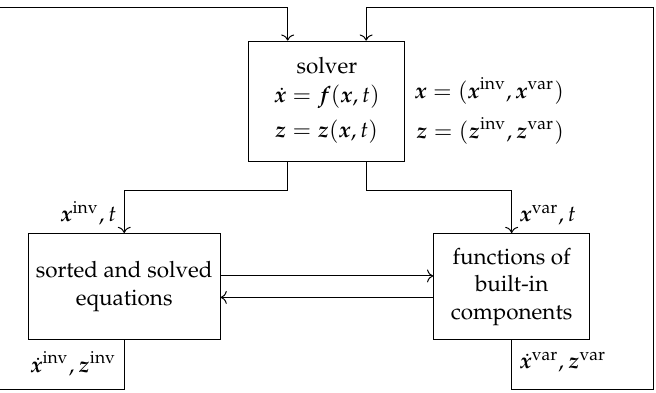
Figure 5. Communication between the solver, the sorted and solved equations, and the functions of the built-in components. The state vector x and the event indicators z are split into an invariant and a variant part: x = ( x inv , x var ) , z = ( z inv , z var ) . The variant parts consist of x j ,1 , x j ,2 , z j ,1 , z j ,2 from all built-in components j (see Figure 3) present in the overall model. The dimensions of the invariant parts are fixed before simulation starts. The dimensions of the variant parts can change at events during